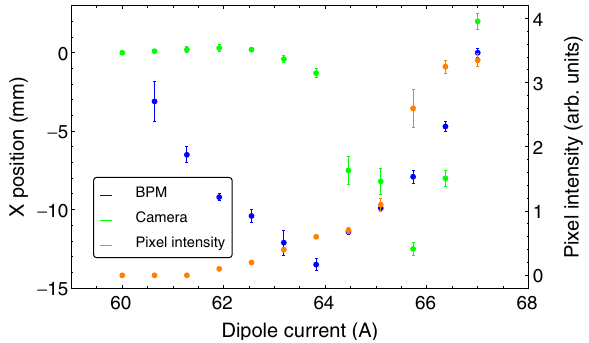
FIG. 27. C2V BPM and camera position, and summed pixel intensity, as a function of the dipole current. The reliable region for the BPMs is reached above a dipole current of 66 A; below this value, the BPM readings are unreliable due to a saturated horizontal